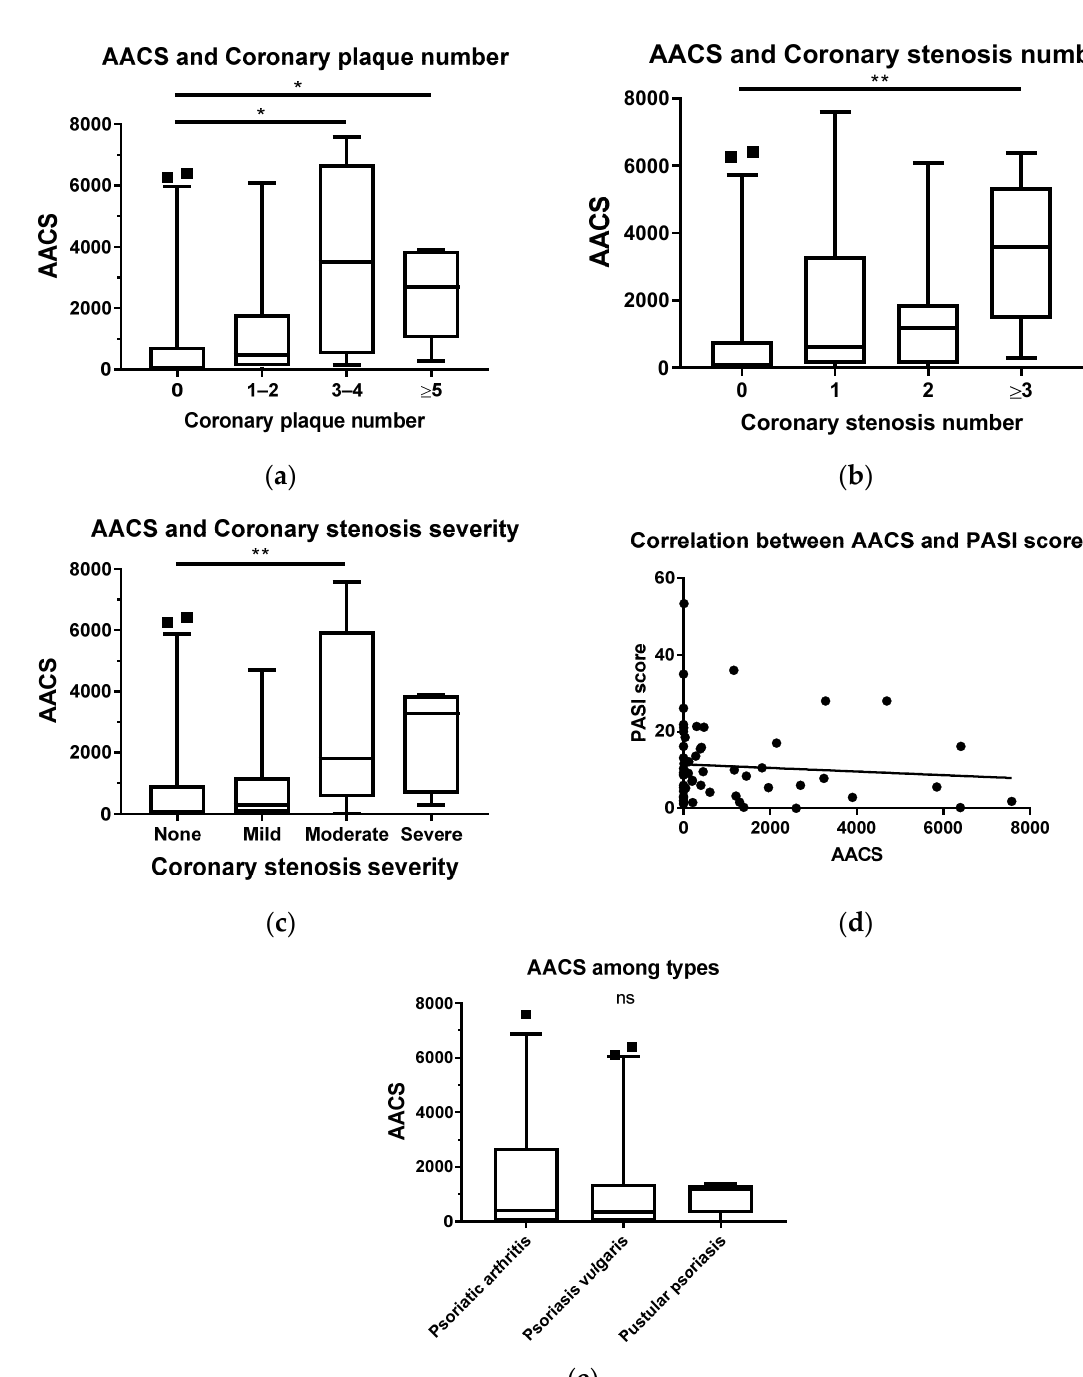
Figure 4. ( a – e ): The association between CCTA and AACS. (with *: p < 0.05, **: p < 0.01, “ns”: not significant) ( (cid:4) AACS values exceeded 95th percentile of those subgroups; • AACS values and the respective PASI scores).